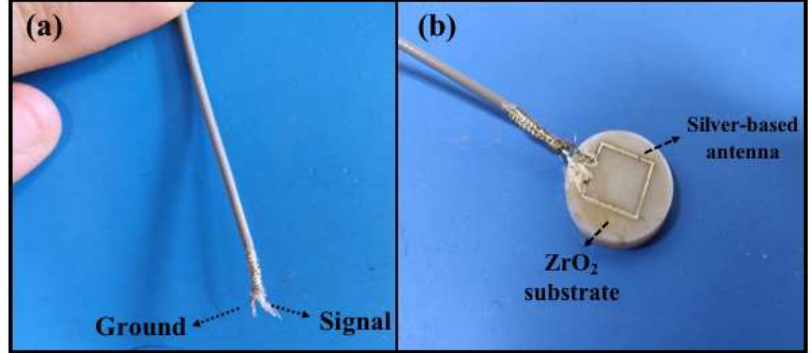
Figure 4. Photographs of the U.FL cable with signal and ground terminations separated ( a ) and of the fabricated antenna ready for testing ( b ).